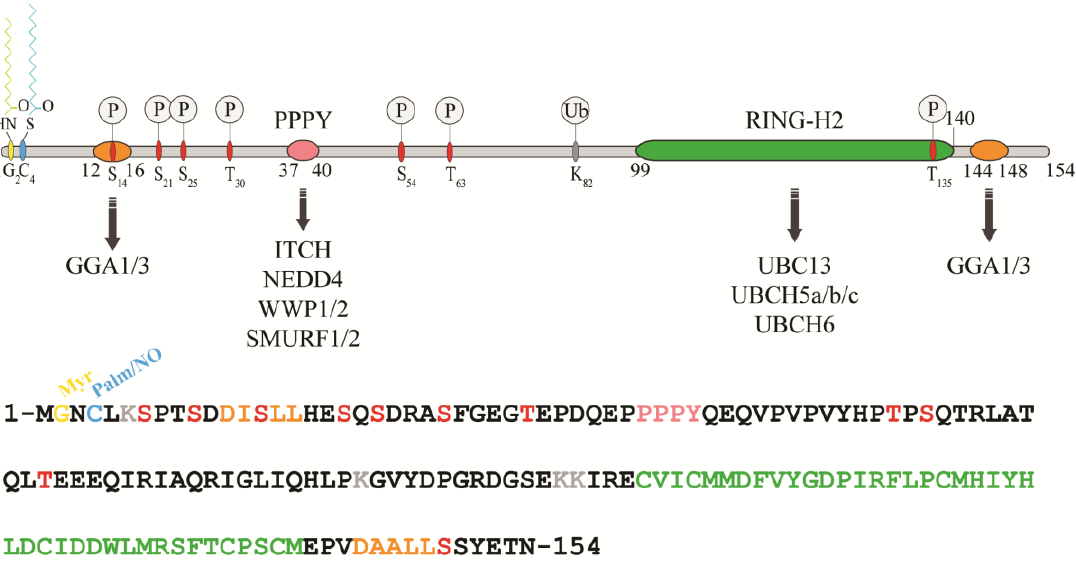
Figure 1. Protein sequence, domain organization and binding partners of the RING-H2 E3-ligase RNF11. Residues identified as target sites for post-translational modifications are shown. Colours legend: the PPY motif is coloured in pink, the RING-H2 domain in green, the myristoylation site is in yellow, the palmitoylation/nitrosylation site in light blue, the di-leucine motifs are in orange, the phosphorylation sites are in red, and the lysine residues are in grey.